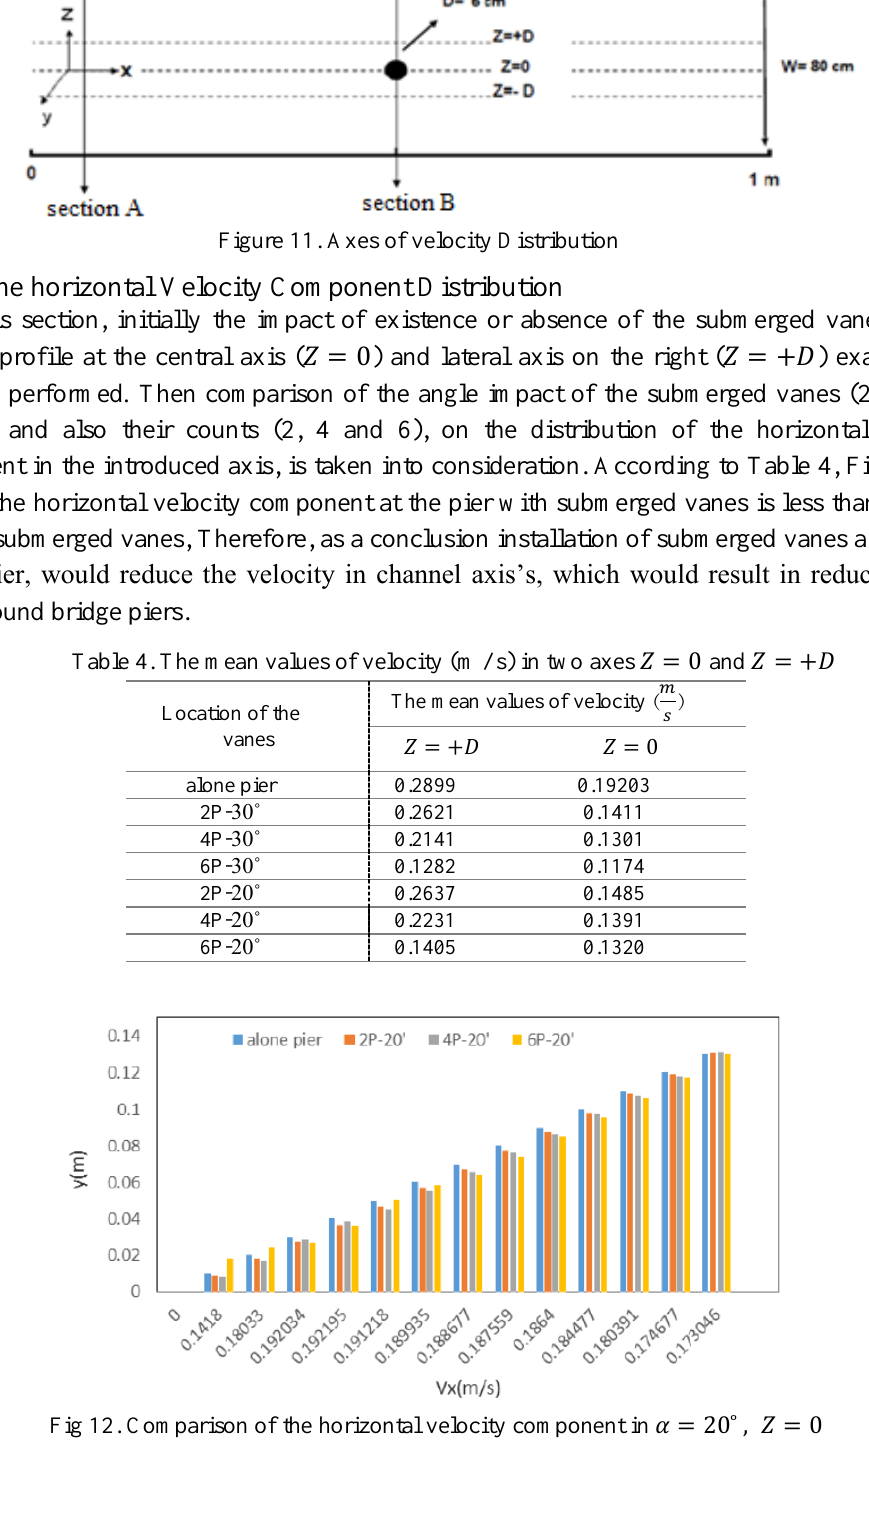
Fig 12. Comparison of the horizontal velocity component in 𝛼 = 20˚ , 𝑍 =